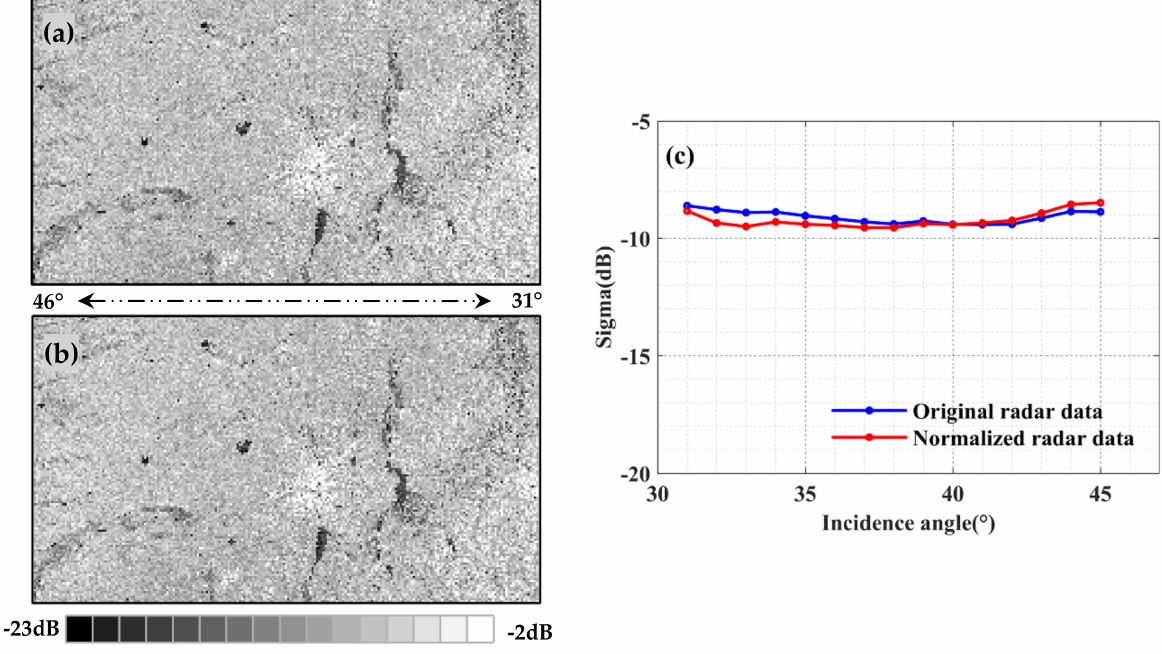
Figure 8. Comparison of VV polarizations for C bands showing the raw ( a ) and normalized ( b ) radar data (17th August, DOY = 229). ( c ) represents the radar data before and after normalization in the study